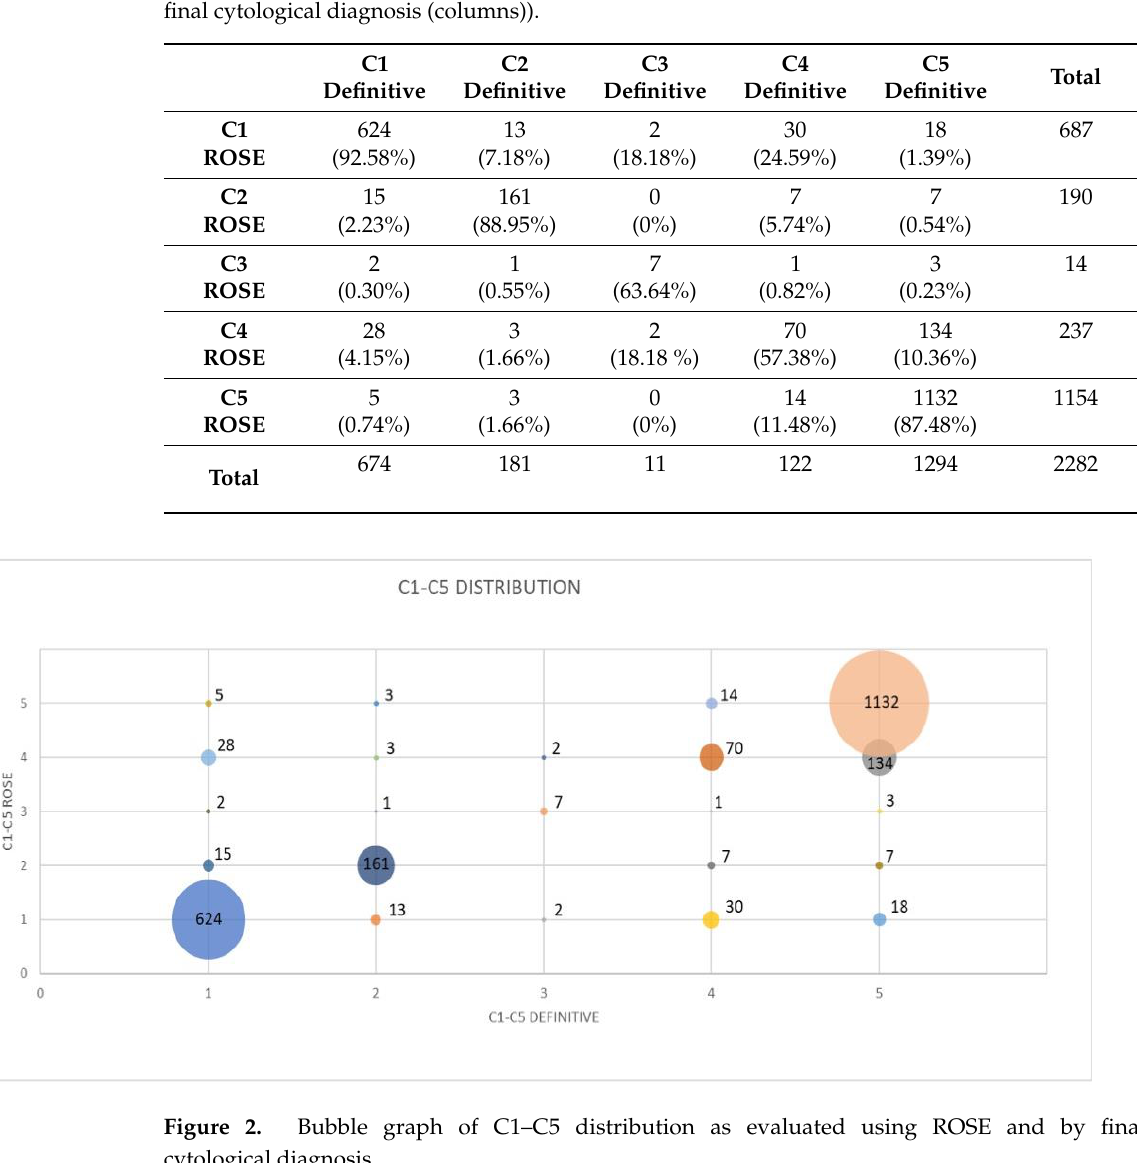
Table 4. Cohen's kappa for “C1-C5 classification” concordance divided for procedures.